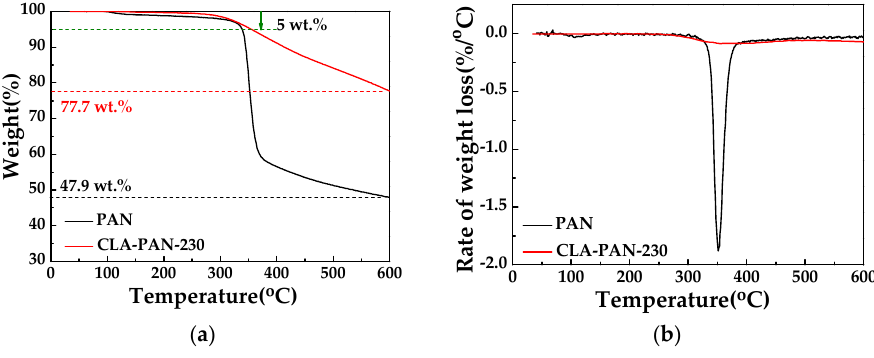
Figure 11. The TGA ( a ) and DTG ( b ) curves of PAN membrane and CLA-PAN-230 membrane.